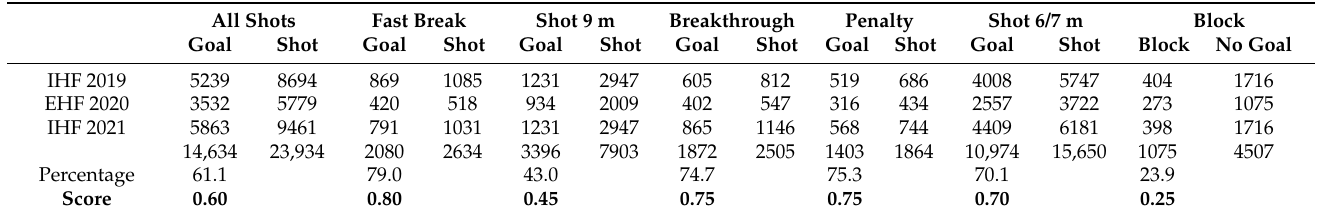
Table 1. Calculation of the different scores based on the percentage (%) of the overall statistics of the 26th Men’s Handball Word Championship 2019 (IHF 2019), the 14th Men’s Handball European